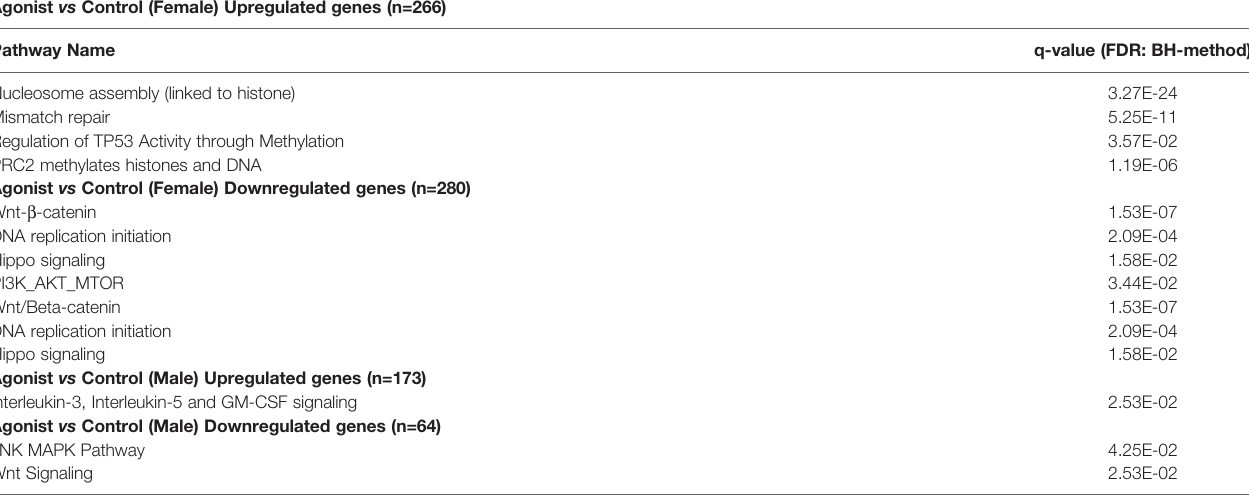
TABLE 2 | ESR1 agonist affects genes involved in crucial HCC pathways. Agonist vs Control (Female) Upregulated genes